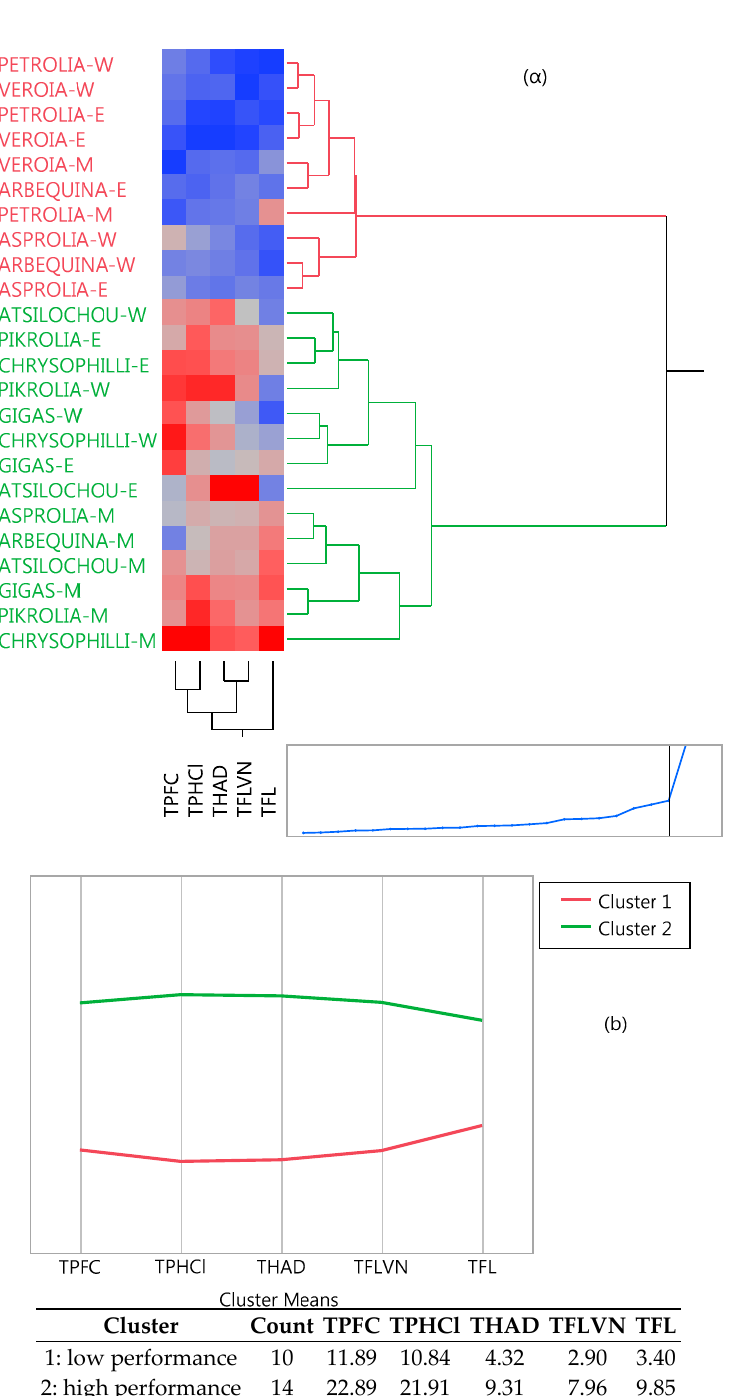
Figure 4. Two-way clustering dendrogram showing ( a ) the position of cultivars in the two clusters and ( b ) the intensity and means of the studied parameters; red and green denotes low and high performance clusters, respectively.